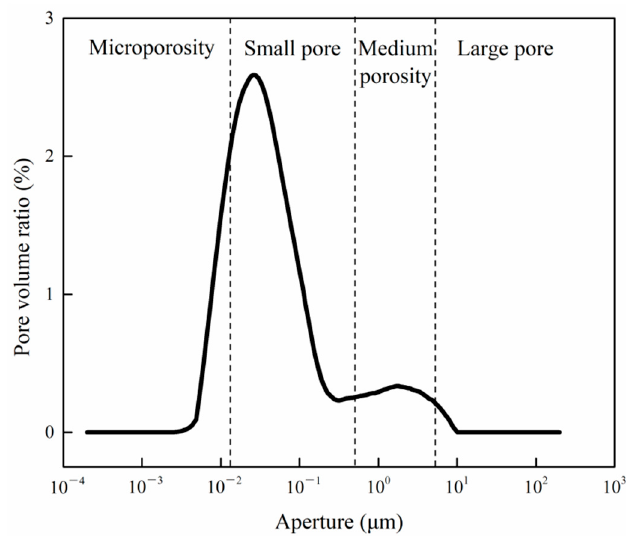
Figure 10. Pore distribution curve of saturated undisturbed loess.